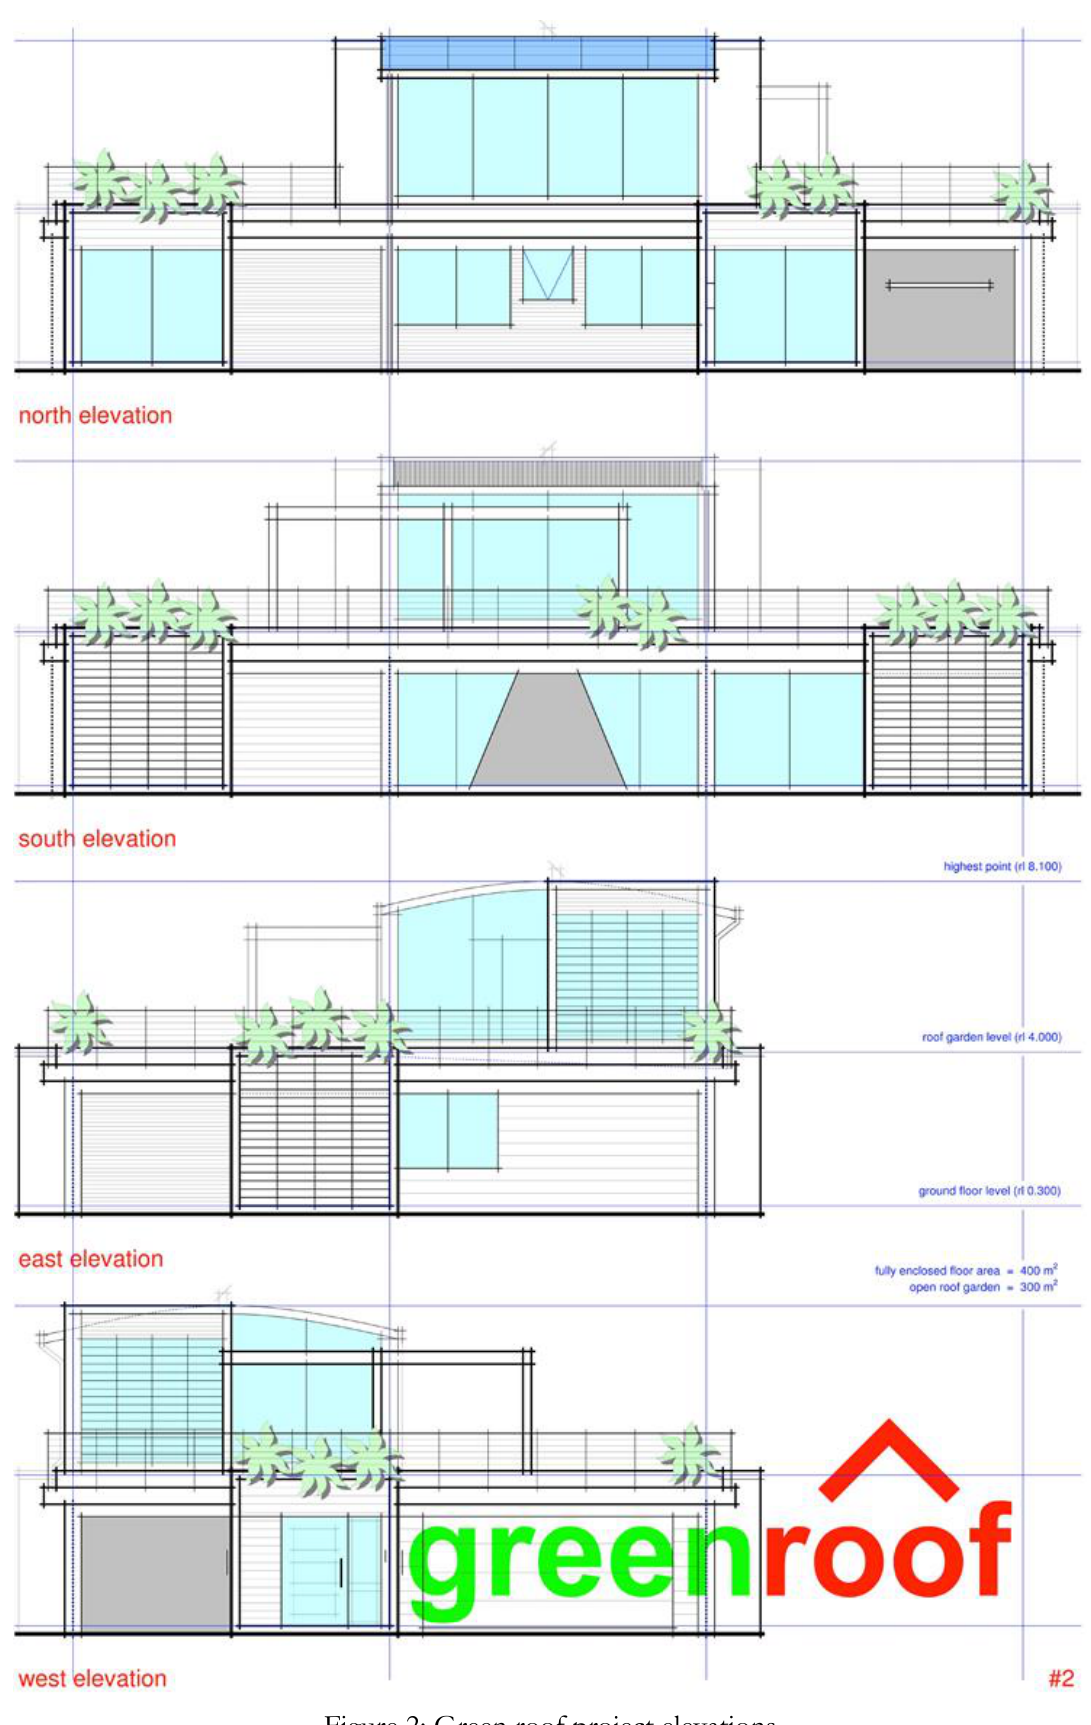
Figure 2: Green roof project